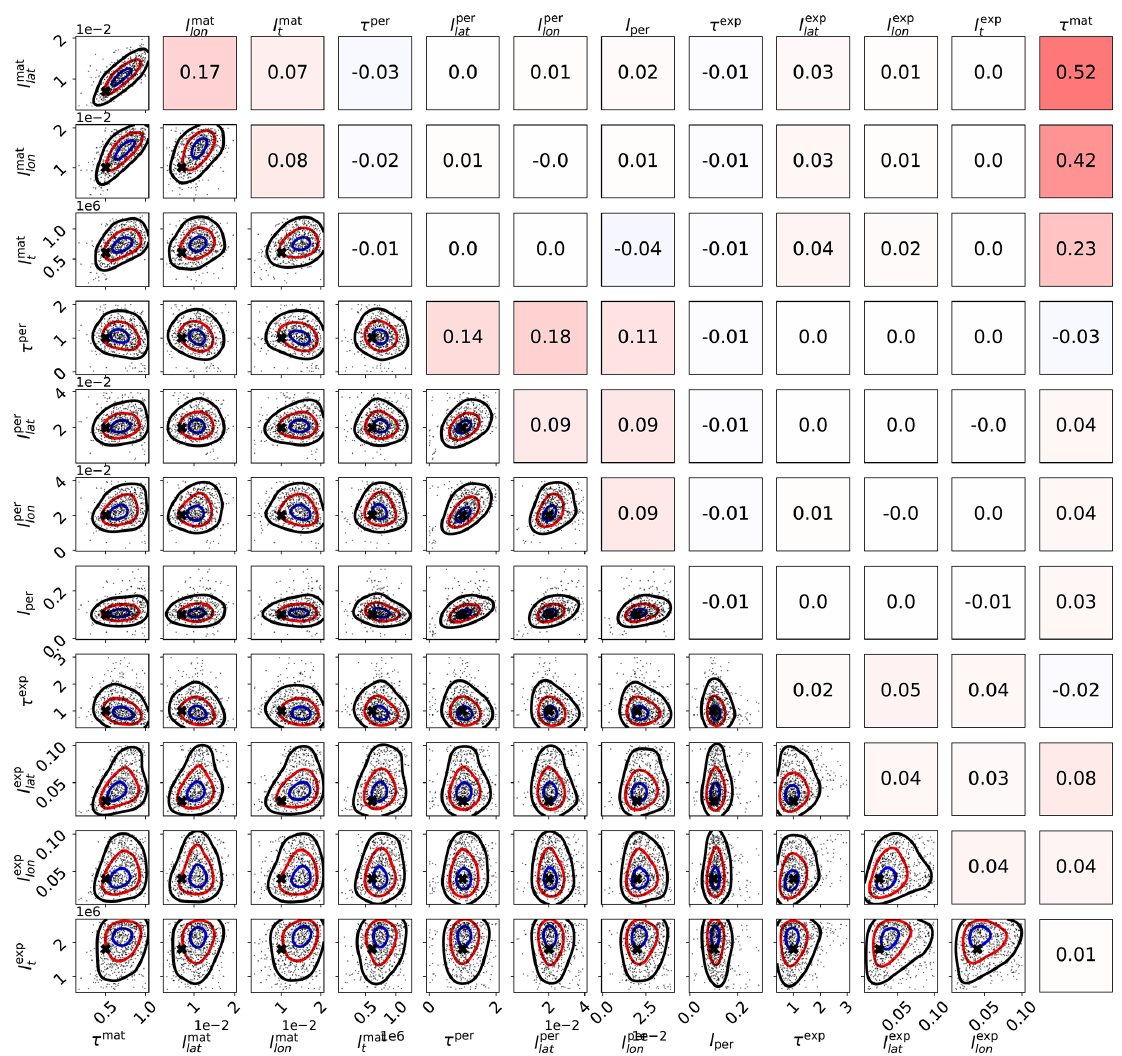
Figure 6. Scaled MCMC posteriors from a synthetic study where data were generated with a multi-scale Gaussian process. The figure demonstrates that even with three subkernels, multi-scale Gaussian process kernel parameters can be recovered. The lower-left part shows the pairwise marginal distributions of the parameters, and the black crosses denote the true parameter values. The axis labels are on the left and below the figure. The upper-right triangle shows sample correlations between the parameters from the chain, with axis labels on the left and on the top. Small within-subkernel positive correlations are present. The contours shown include 85% (black), 50% (red), and 15% (blue) of the posterior